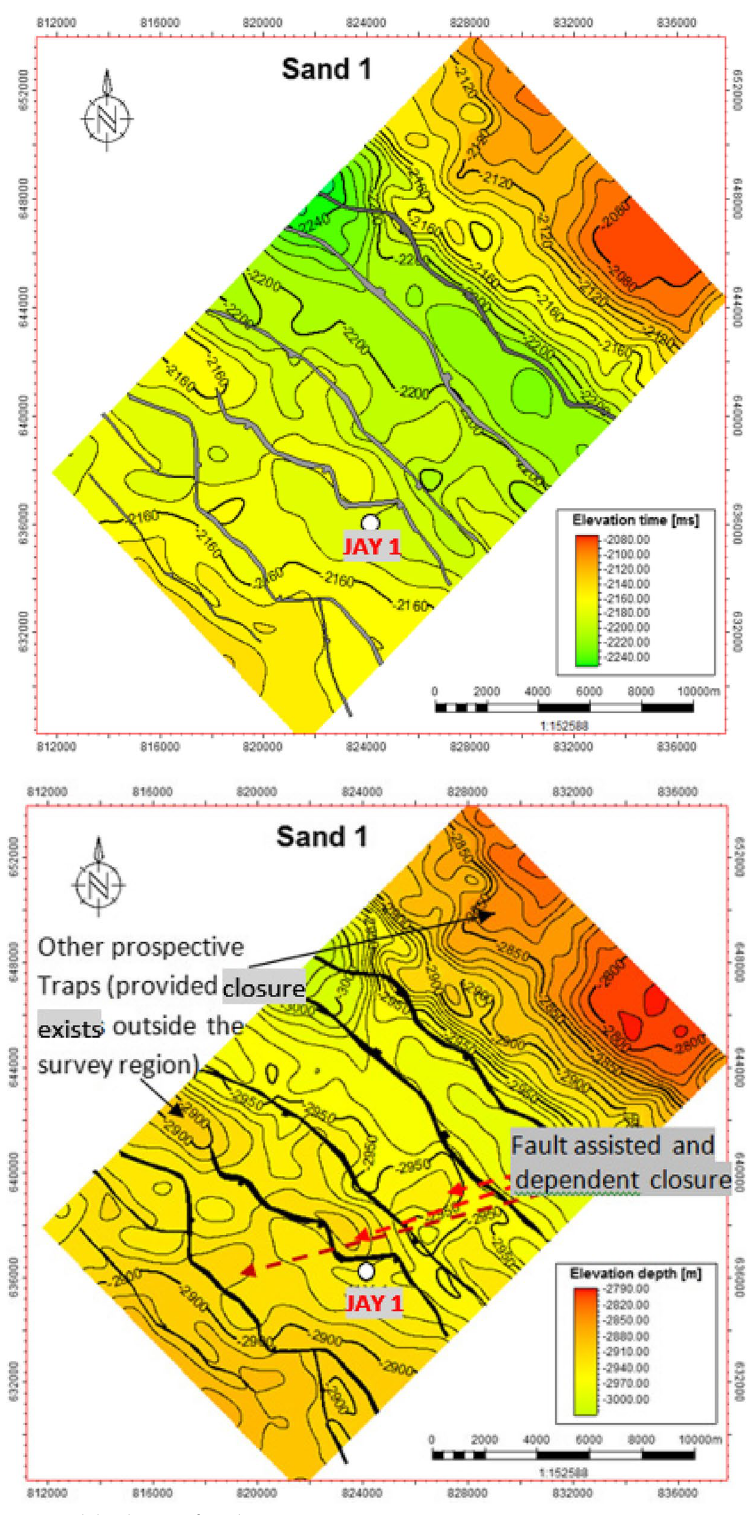
Fig. 13 Time and depth map of sand